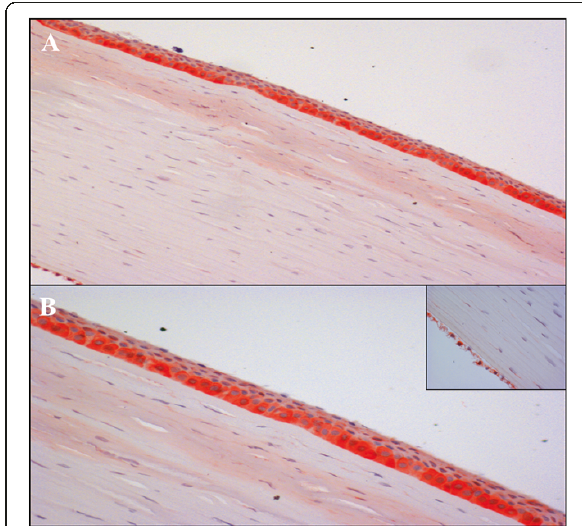
Figure 4 Immunohistochemical profile of healthy corneal tissue. Positive TCTP staining was observed in the basal and intermediate cell layers of the corneal epithelium (A-B); weak and focal staining was observed in keratocytes and along the endothelial cell layer (B, inset) [A, original magnification (O.M) 2.5x; B, O.M. 5x; inset, O.M. 2.5x].